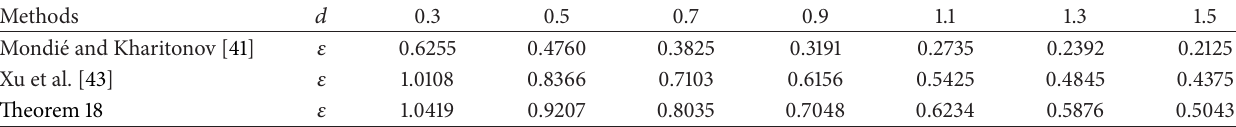
Table 4: Maximum upper bound of 𝜀 with different parameter 𝑑